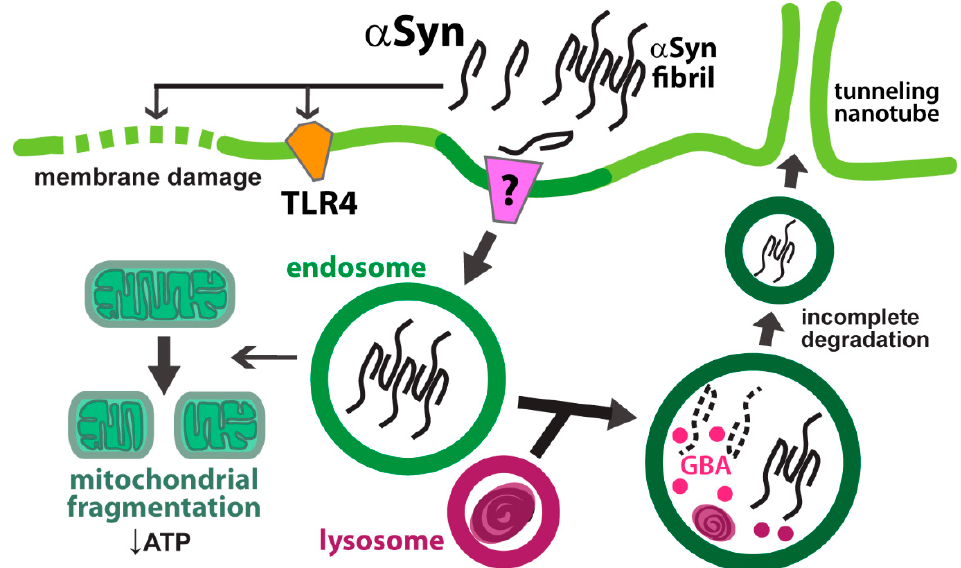
Figure 3. Endolysosomal trafficking and cellular impact of α Syn in astrocytes. Extracellular α Syn causes plasma membrane damage and activates cytokine production via toll-like receptor 4 (TLR4) in astrocytes. Accumulation of internalized α Syn fibrils in the endosomal compartments results in fragmentation of mitochondria and reduced ATP production. Lysosomal enzyme GBA is required for the degradation of α Syn. Incomplete degradation augments fibril formation and promotes cell-to-cell transmission via tunneling nanotubes, which connect to other astrocytes and neurons.